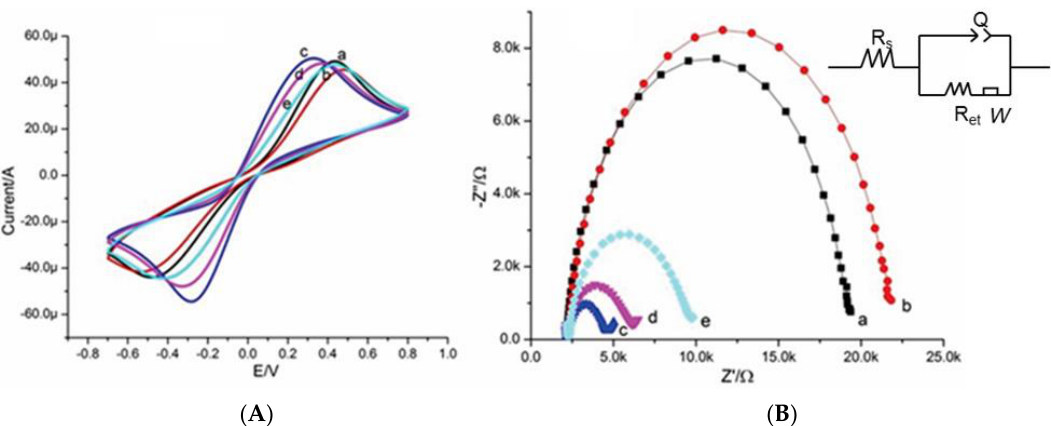
Figure 4. ( A ) cyclic voltammograms of 2.0 mM [Fe(CN)6]4-/3-probe at scan rate of 100 mV/s and ( B ) Nyquist plots for (a) bare SPCE, (b) SPCE/MWCNT modified electrode, (c) SPCE/MWCNT/N-(3-dimethylaminopropyle)-N-ethyle-carbodiimide (EDC) activated modified